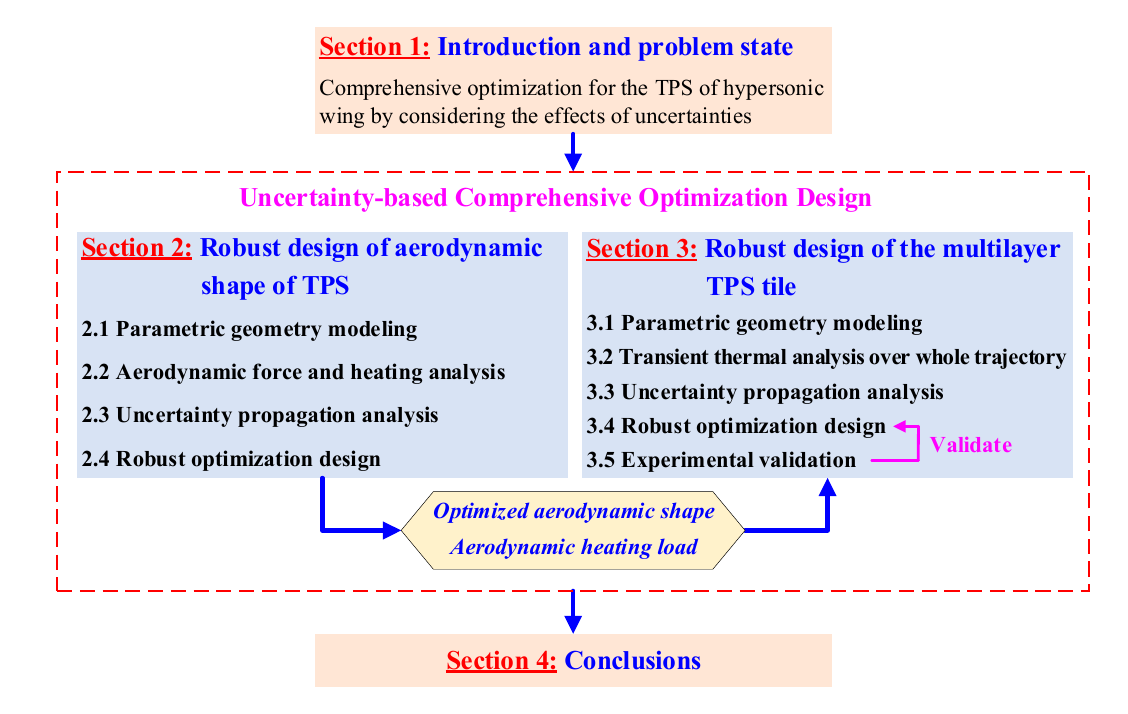
Figure 1. Framework of the manuscript.